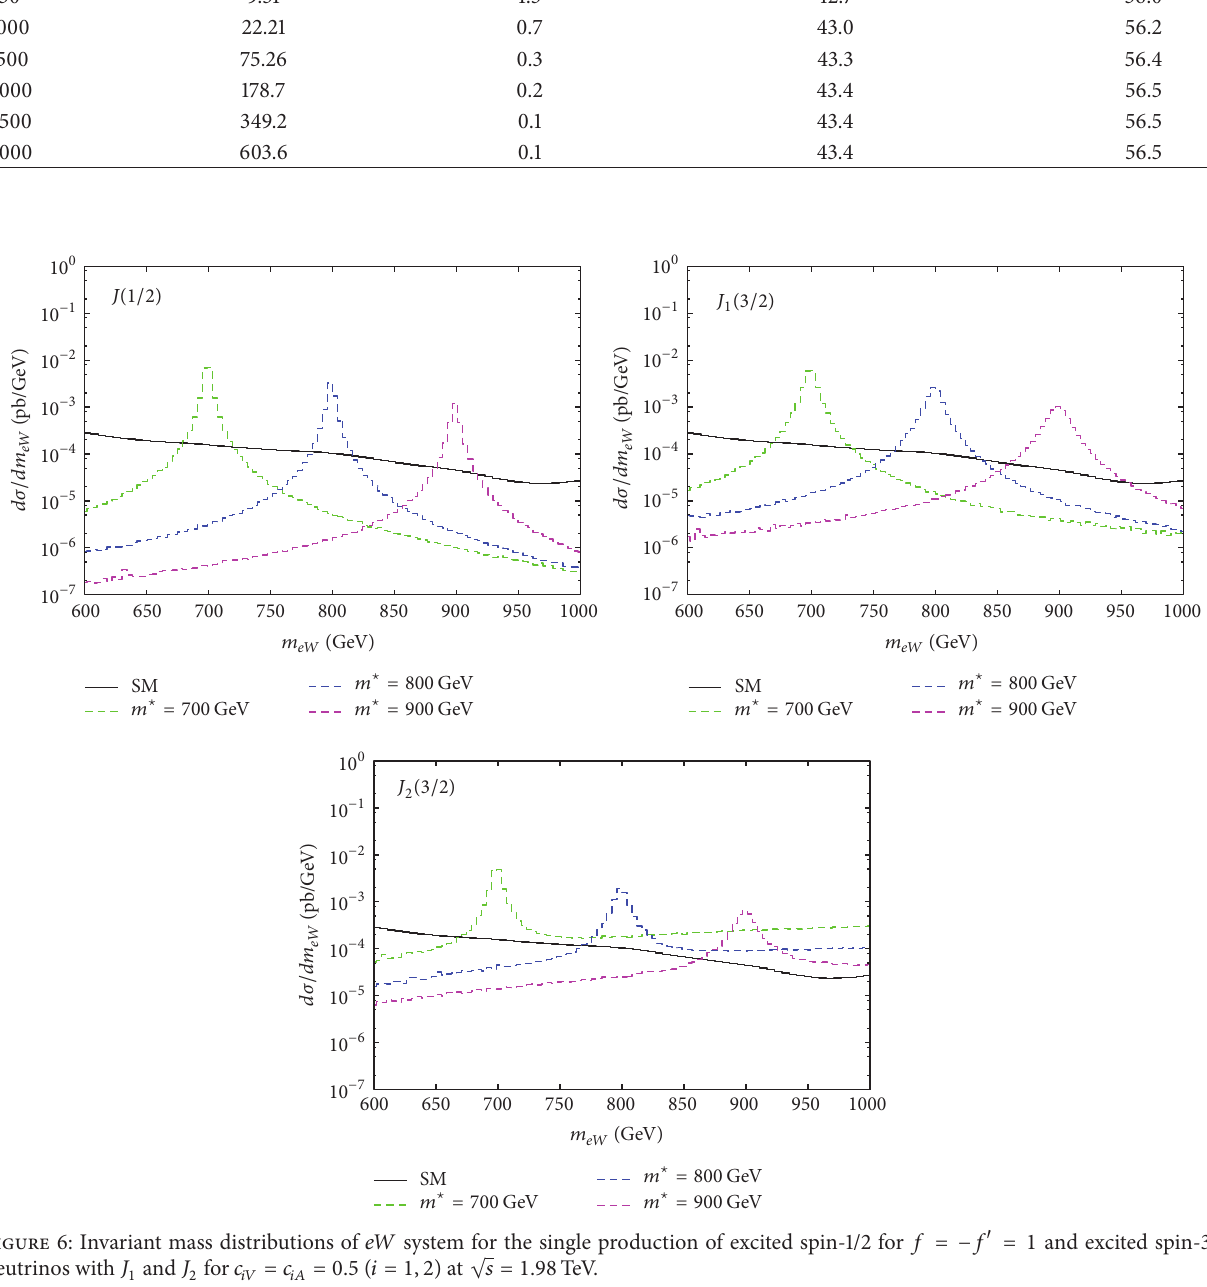
for the 𝑐 𝑖𝑉 − 𝑐 𝑖𝐴 (𝑖 = 1, 2) and 𝑓 − 𝑓 󸀠 couplings for the masses 𝑚 ⋆ = 400 GeV at √𝑠 = 1.3 TeV and 𝑚 ⋆ = 800 GeV at √𝑠 = 1.98 TeV. The values which we chose in our calculations for the coupling parameters ( 𝑐 𝑖𝑉 = 𝑐 𝑖𝐴 = 0.5 for the excited spin-3/2 neutrinos and 𝑓 = −𝑓 󸀠 = 1 for the excited spin-1/2 neutrinos) are compatible with the contour